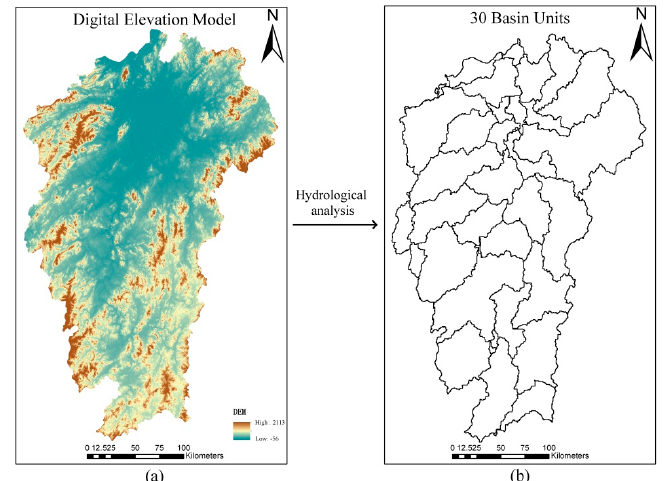
Figure 3. ( a ) 30 m ‘ASTER Global Digital Elevation Model’ (ASTGTM) digital elevation model (DEM) data and ( b ) the watershed units (calculated from a).